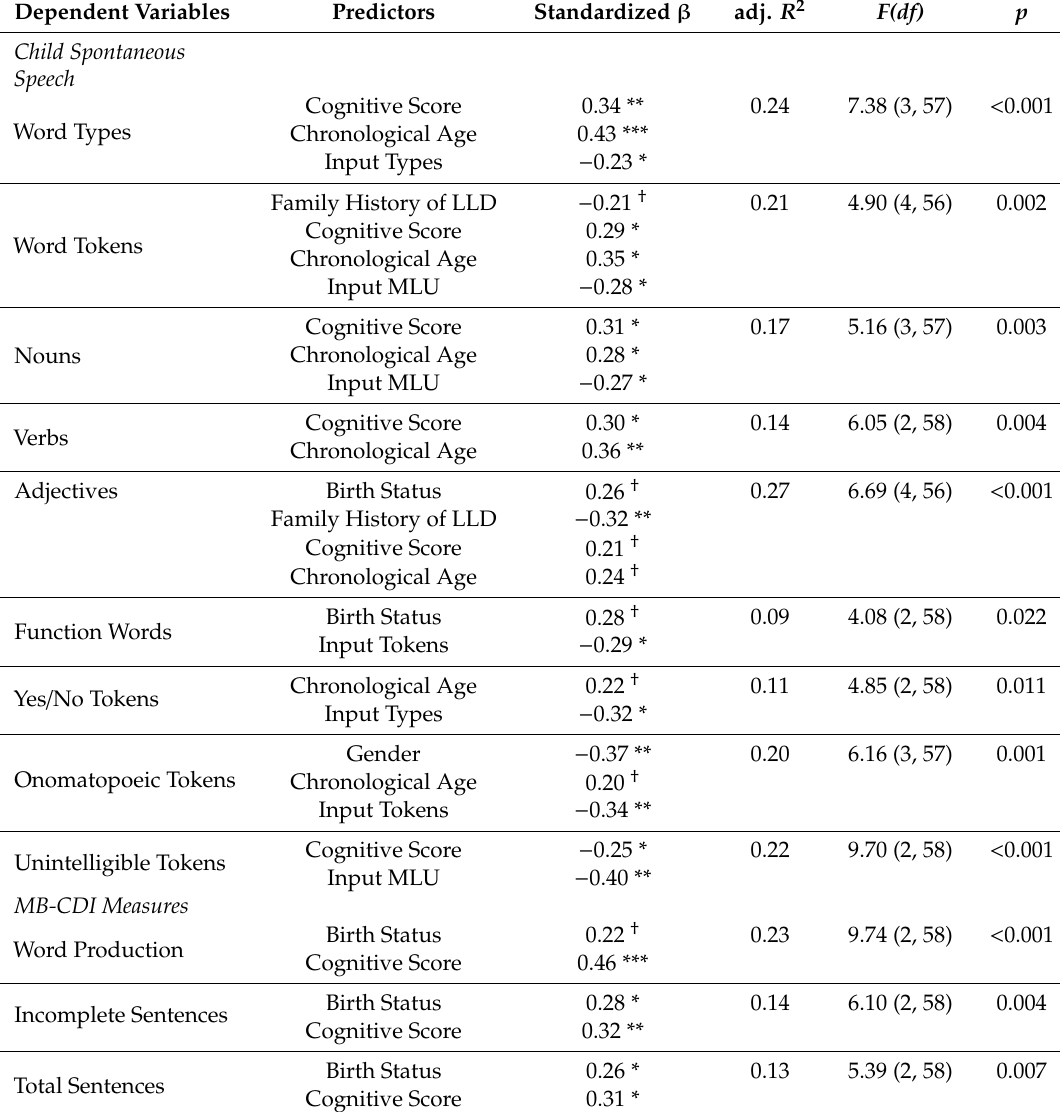
Table 4. Results of multiple linear regression analyses on child spontaneous and reported (MB-CDI Words and Sentences Short Form) speech